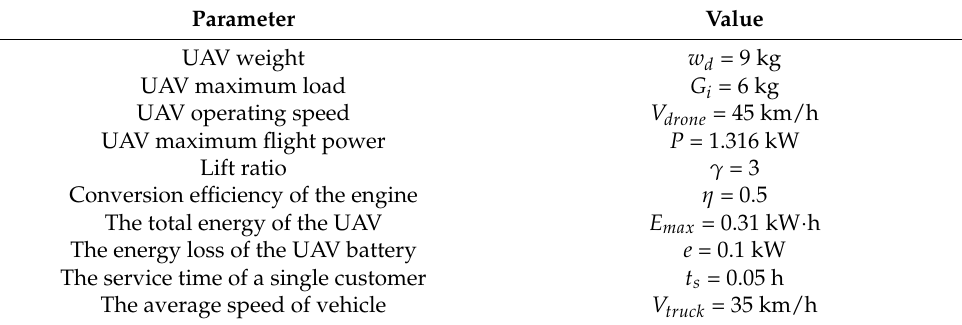
Table 2. Simulation parameters and